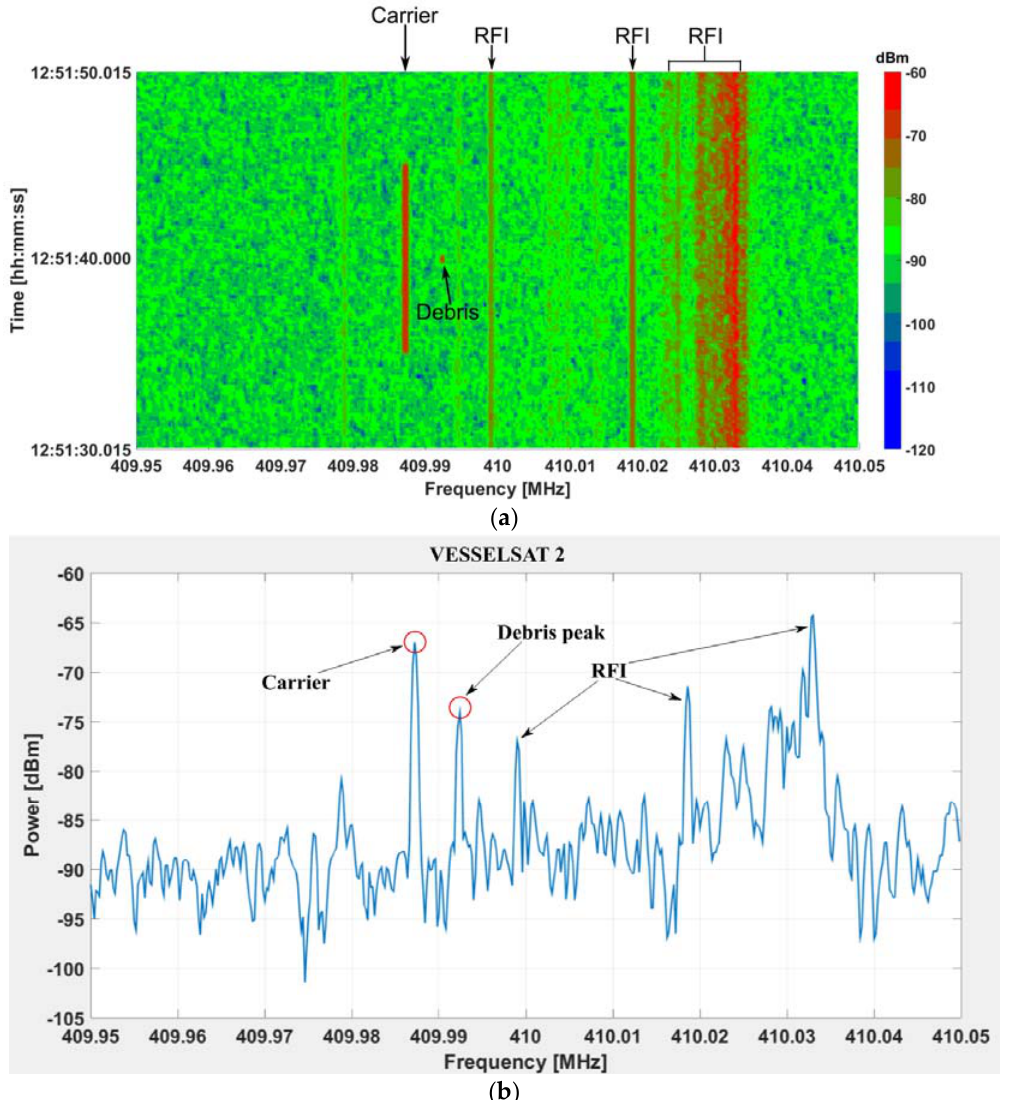
Figure 10. Debris VESSELSAT 2: ( a ) spectrogram; ( b ) screenshot of the spectrum analyzer at the center of the visibility interval (Table 4).